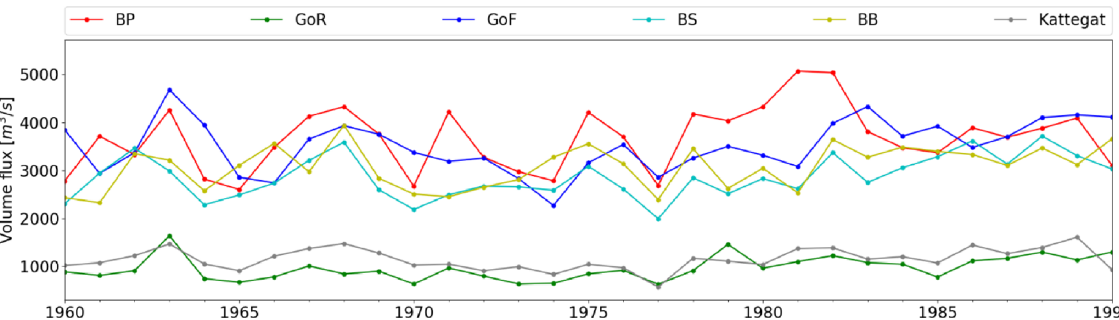
Figure 2. Annual mean freshwater input to different subbasins of the Baltic Sea from the BMIP runoff forcing for the years 1960–1990. Figure adopted from Väli et al. (2019). BP is Baltic proper, GoR is the Gulf of Riga, GoF is the Gulf of Finland, BS is the Bothnian Sea, and BB is Bothnian